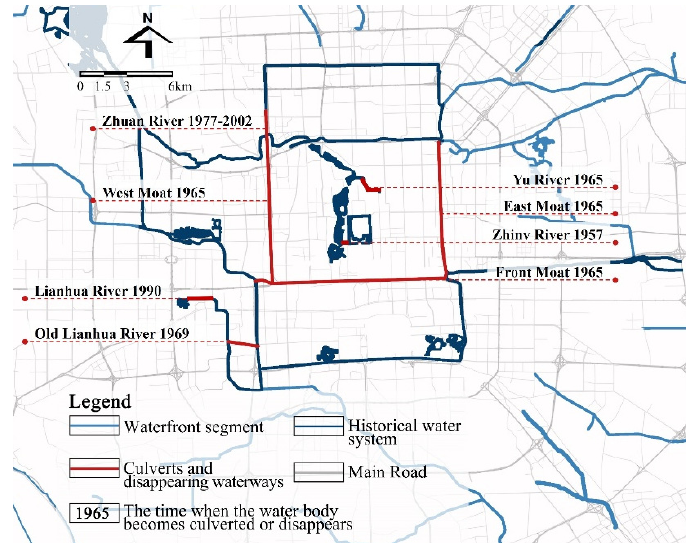
Figure 11. The culverts and disappearing waterways in Beijing